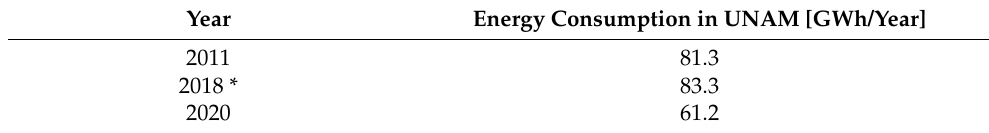
Table 1. Total energy consumption at CU-UNAM (Source: Escobedo et al. [11] and